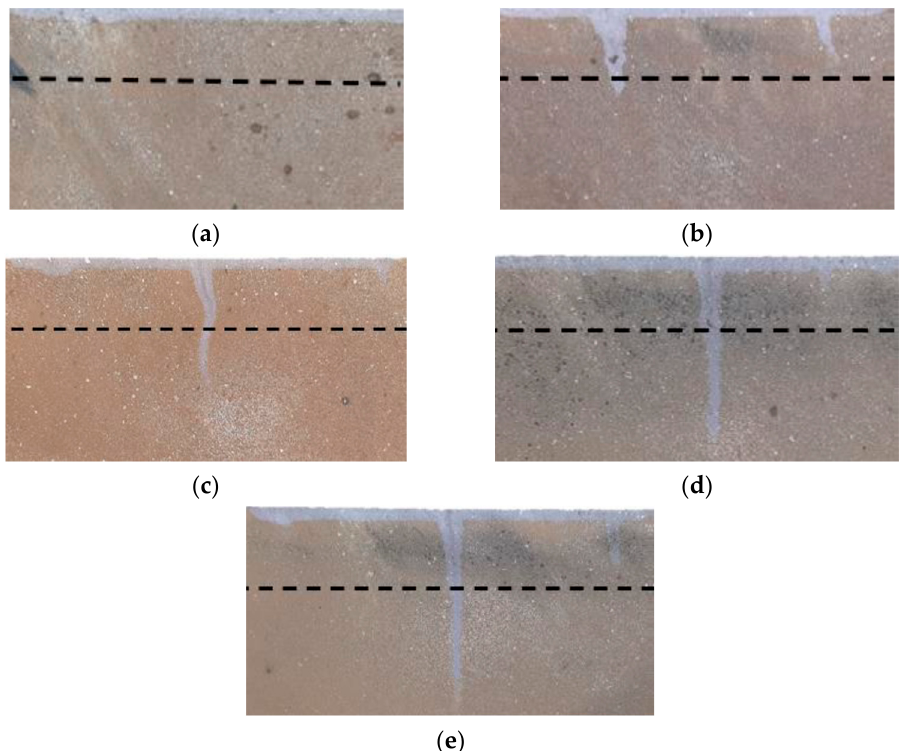
Figure 20. Chloride penetration profile for the C-V ( a ), 3D-0 ( b ), 3D-10 ( c ), 3D-20 ( d ) and 3D-30 ( e ) beams, showing the 20 mm cover depth with the dashed line, after 18 weeks of chloride exposure (9 cyclic wetting and drying cycles).